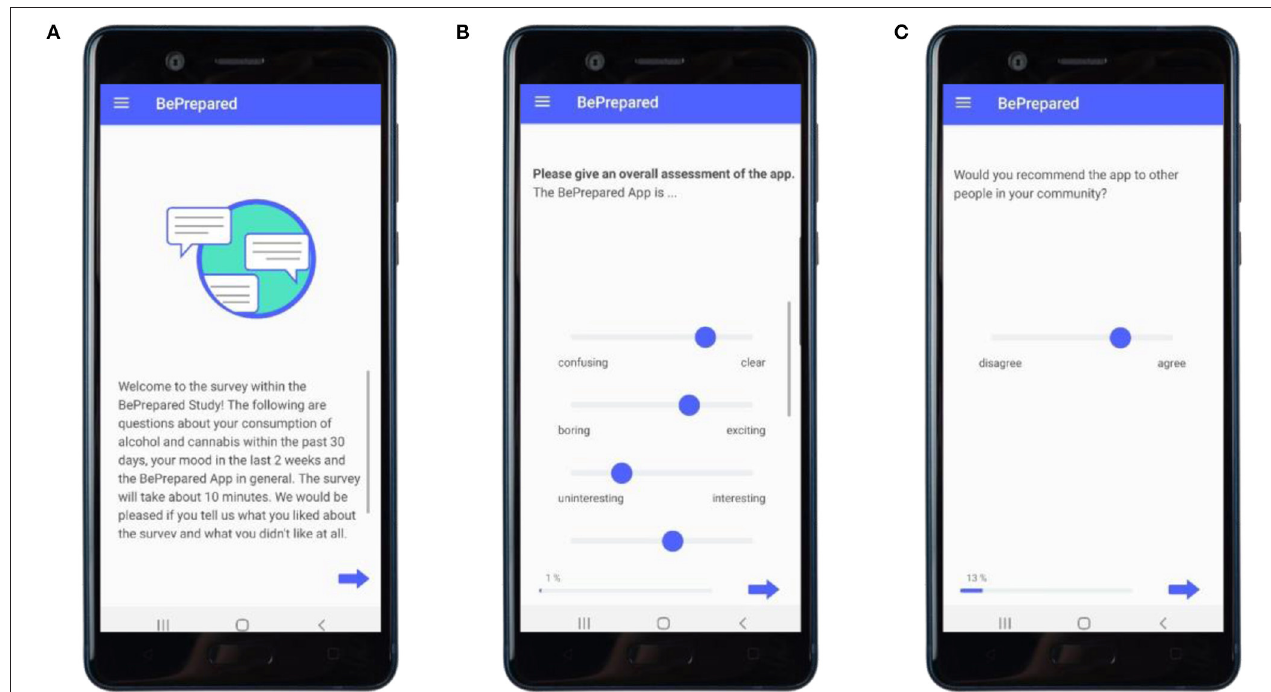
FIGURE 7 | Implementation of the follow-measurements in the app. (A) Entry screen. (B) Examplary item of the overall assessment on the app. (C) Example item on cultural sensitivity.